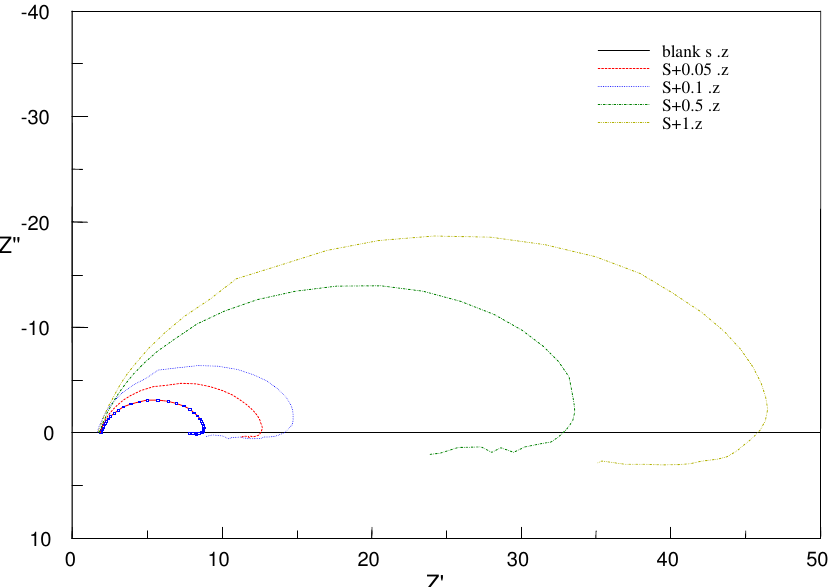
Figure 2 . Nyquist plot of mild steel immersed in 1N H